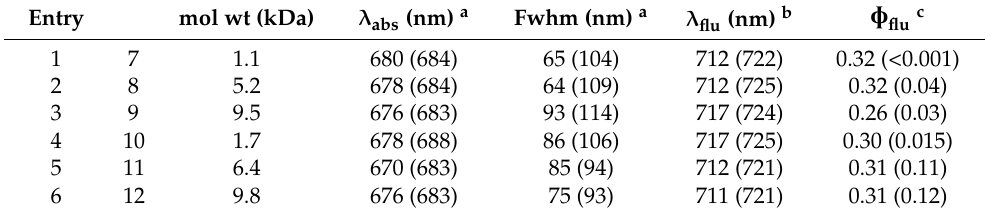
Table 1. Photophysical characteristics of pegylated NIR-AZAs 7 – 12 .